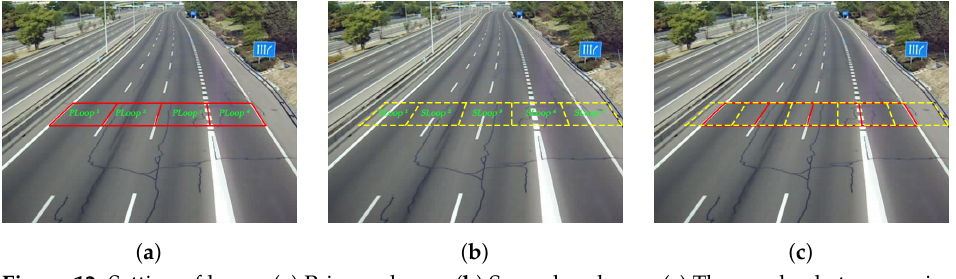
Figure 12. Setting of loops. ( a ) Primary loops. ( b ) Secondary loops. ( c ) The overlap between primary loops and secondary